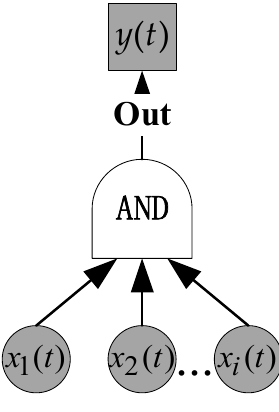
Figure 2. The RDFTA AND logic gate. Table 3. The quantitative operation rules of the A ND gate.